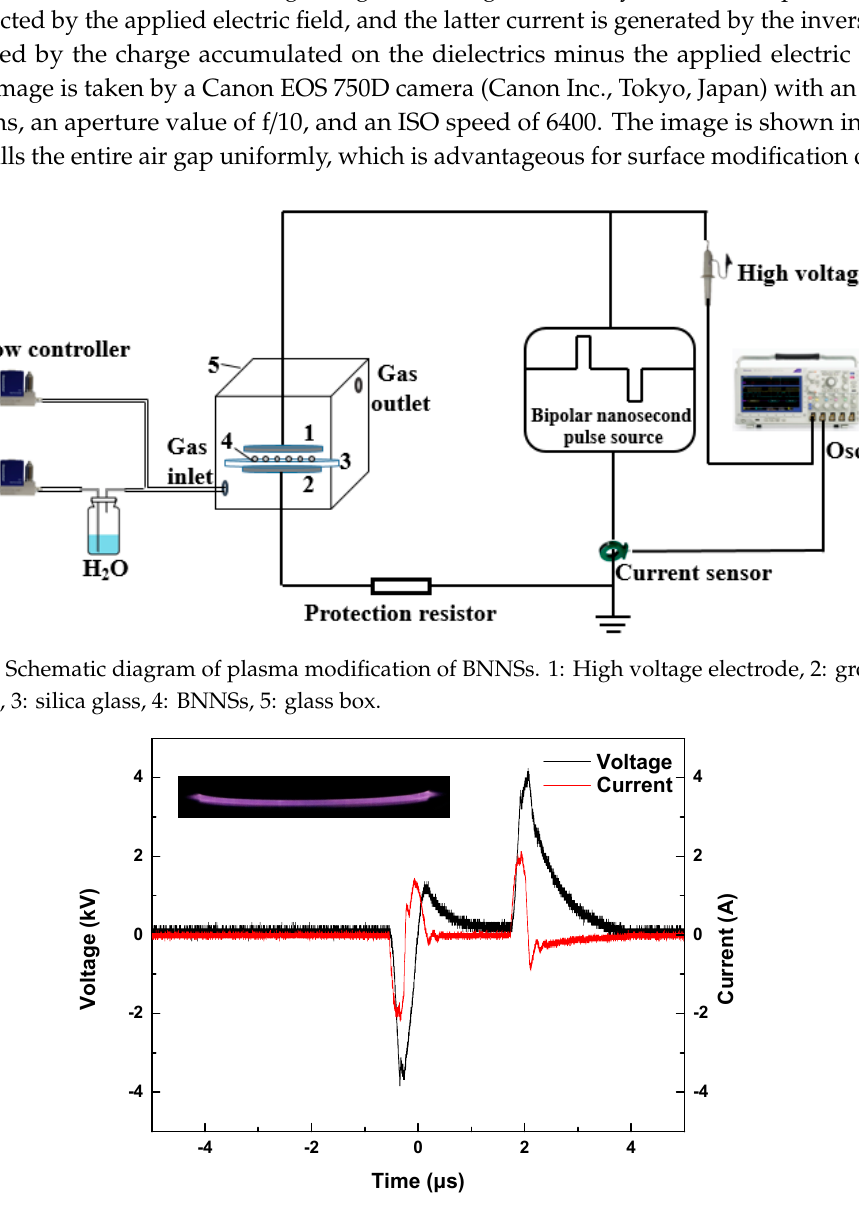
Figure 3. Voltage and current waveforms of dielectric barrier discharge (DBD) and image of plasma.